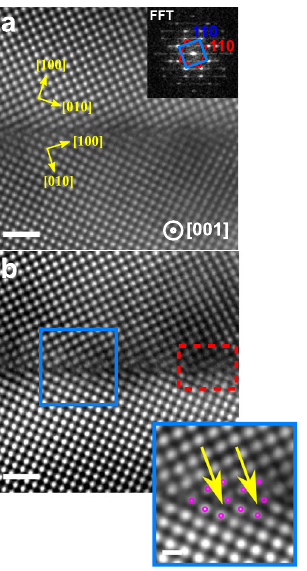
Fig. 2 Atomic structure of the Σ 5 (3 1 0 )[0 0 1] GB in the Fe-4at% Al bi-crystal. a Raw HAADF-STEM image and corresponding FFT. From the FFT the misorientation angle is determined to 38 ∘ . b Fourier- fi ltered image of ( a ). The inset shows a magni fi ed view of the kite-type structural GB units highlighted by magenta dots. The yellow arrows indicate positions where weak contrast in the kite centers is observed. The scale bar in ( a and b ) is 1 nm, while the inset has a scale bar of 500 pm.